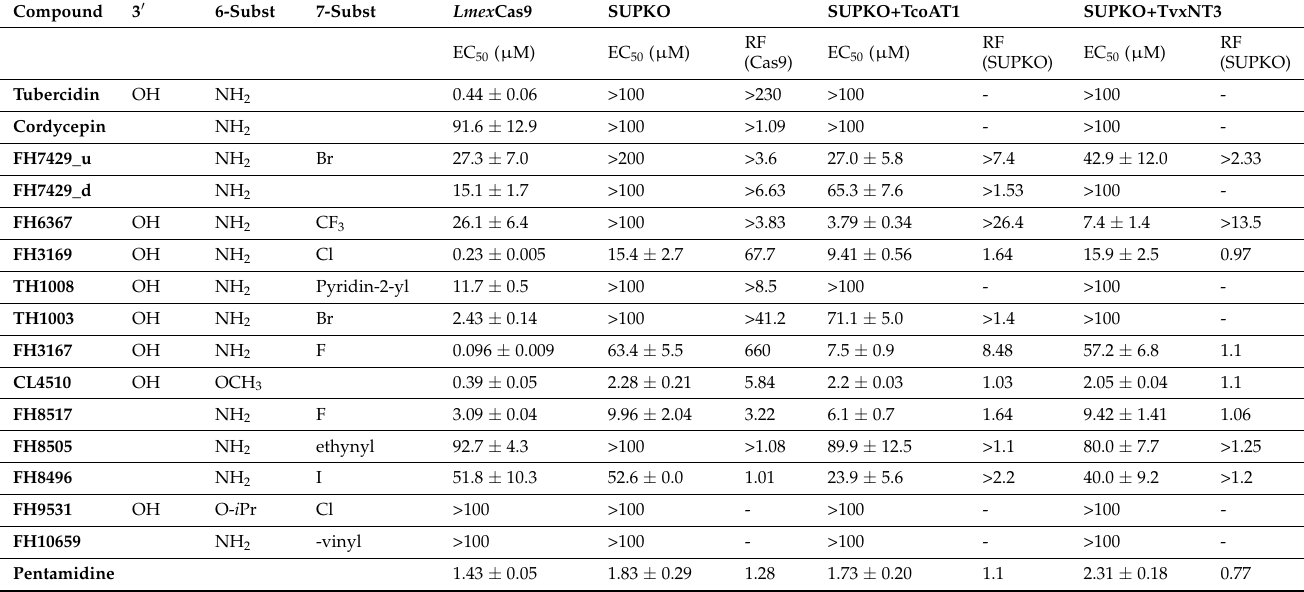
Table 5. Effect of the expression of nucleoside transporters on the sensitivity of tubercidin